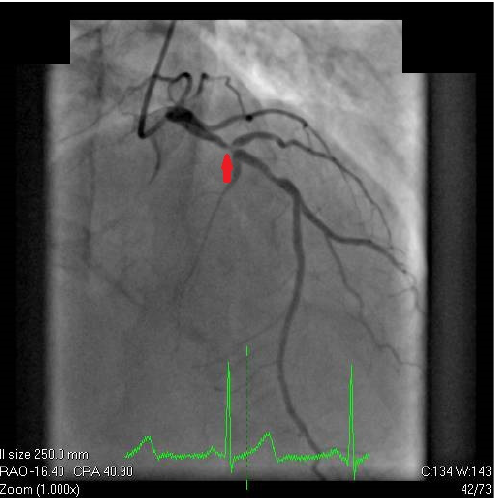
Figure 4. Transthoracic echocardiography: color Doppler echocardiographic images in apical five chamber view and continuous wave Doppler spectrum from the left ventricular outflow tract showed aortic regurgitation flow. The pressure halftime (PHT) was 0.412 seconds.